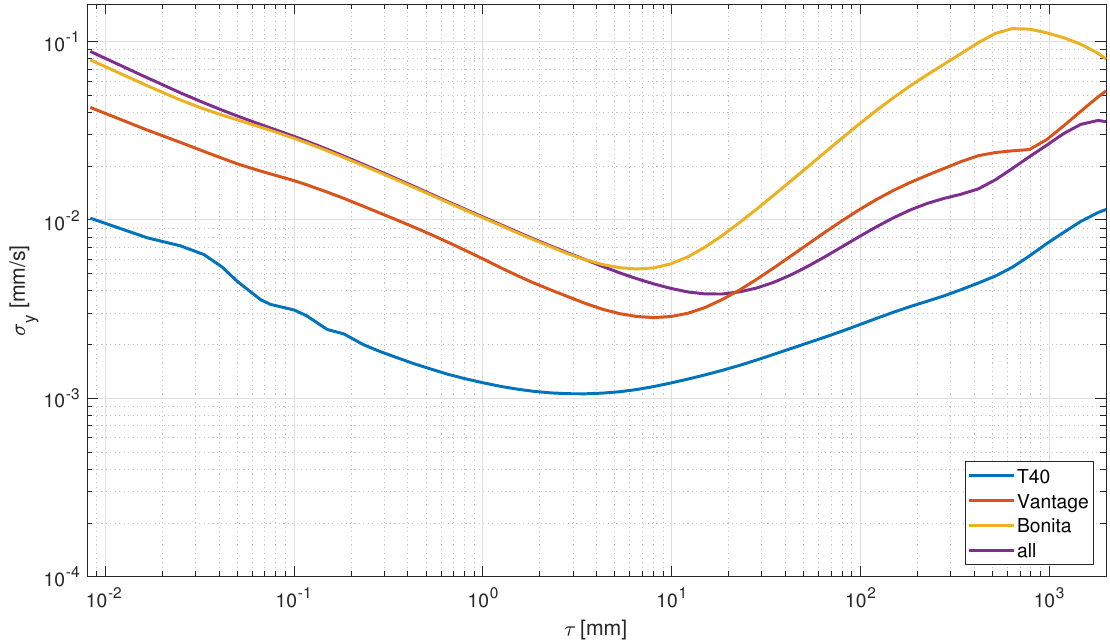
Figure A1. Exemplary Allan deviation for supplementary recording— z 1